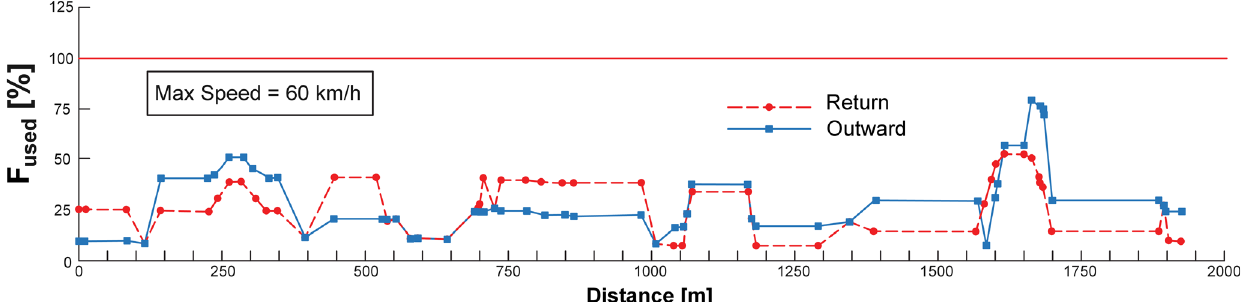
Fig. 13 Friction Diagram of Site PP1 in wet conditions, in case of compliance with the speed limit of 60